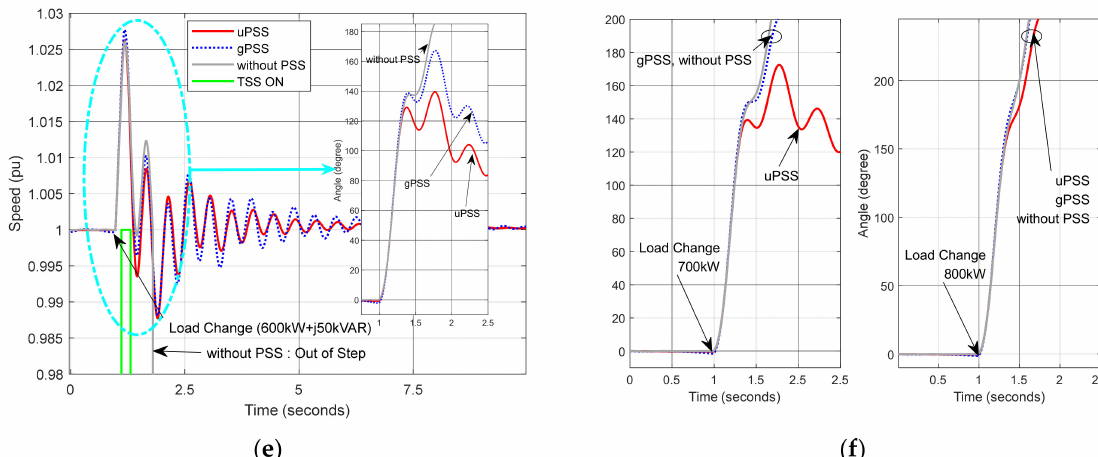
Figure 13. Performances of low-frequency stabilizing (LFS) and TSS at the load change (system load: 3 MW; initial loading of SG: 0.5 pu (1 MW); reference voltage of AVR: 1 pu): ( a , b ) in the case of 300 kW load change, ( c , d ) in the case of 500 kW load change, ( e ) in the case of 600 kW load change, and ( f ) in the case of 700 kW and 800 kW load change (every case is unstable at 800 kW load